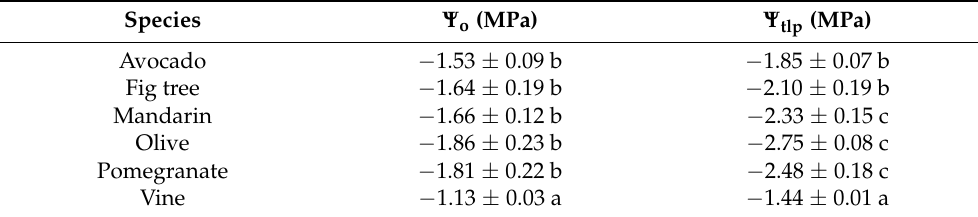
Table 4. Osmotic potential at full turgor ( Ψ o ) and water potential at turgor loss point ( Ψ tlp ) of six fruit tree